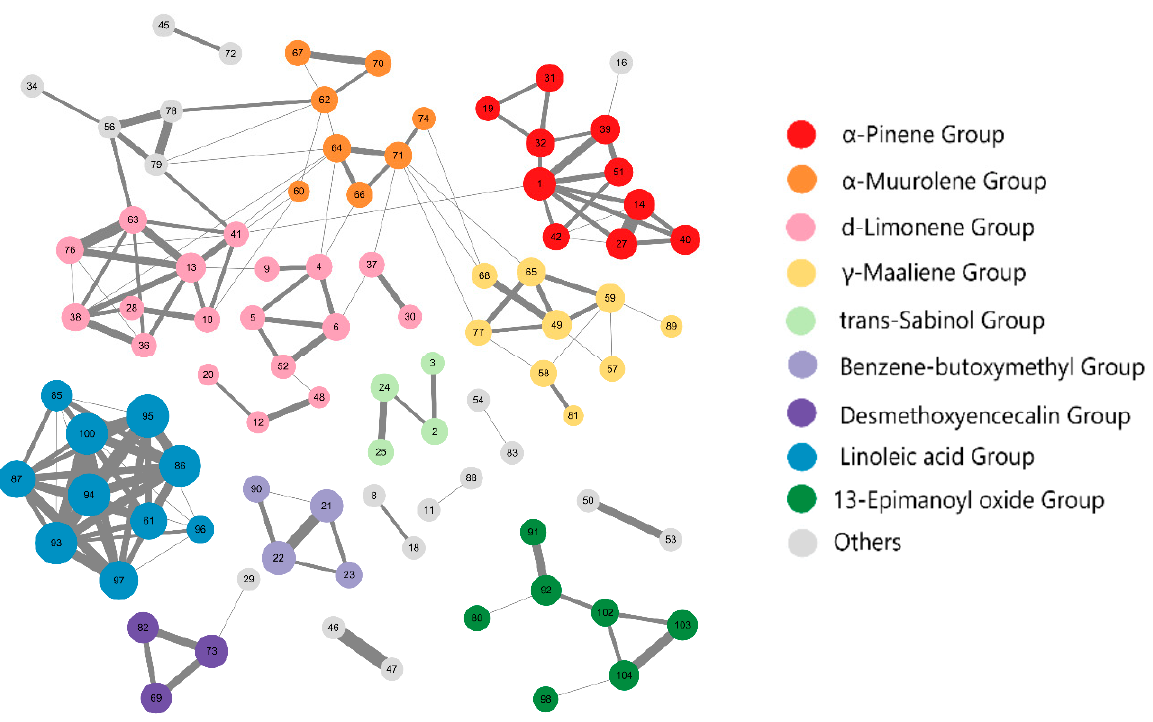
Figure 2. Chemical space network of 91 compounds. Nine groups with more than two molecules are colored, other groups with greater distance or less than three molecules are shown in